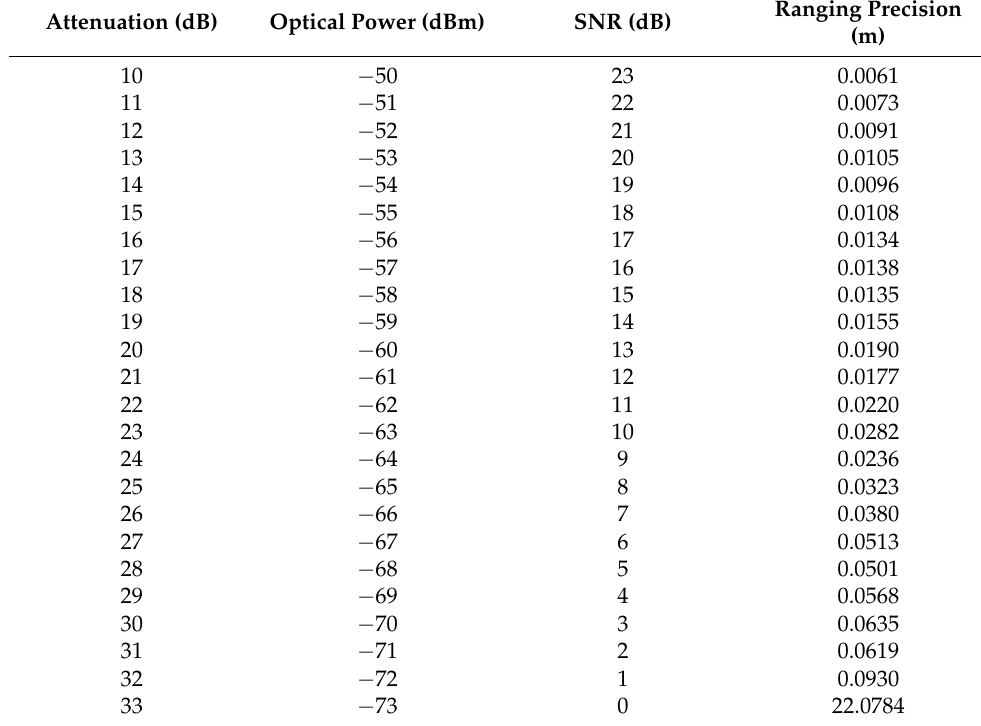
Table 2. Ranging precision under different powers of signal light conditions.